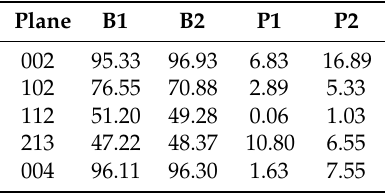
Table 6. Values of textural degree index DR (%).